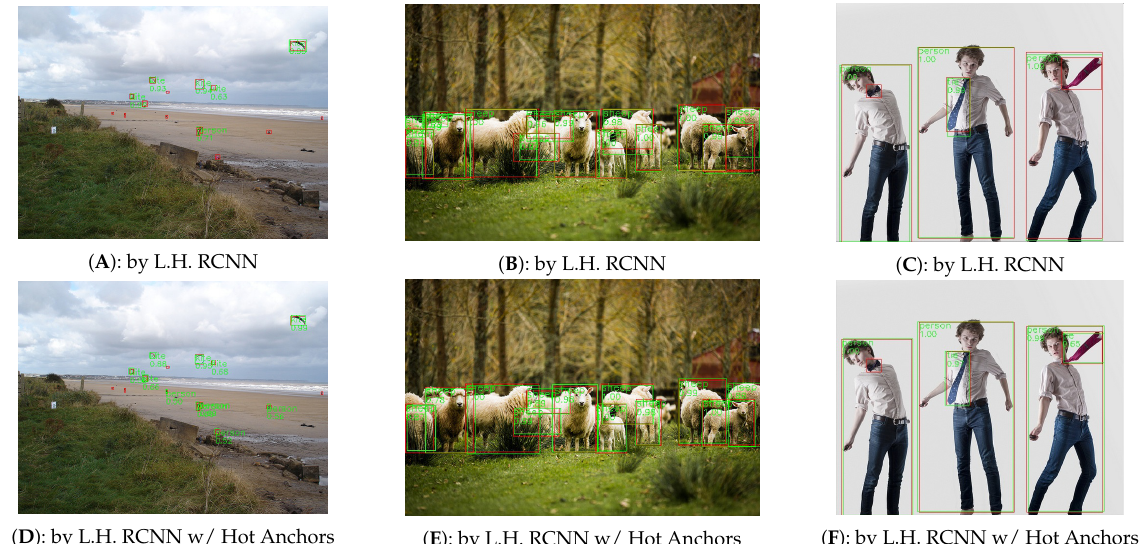
Figure 8. The comparison of detection results between Light Head RCNN [10] and Light Head RCNN with Hot Anchos. The ( A – C ) are the results detected by Light Head RCNN (Abbreviated as L.H. RCNN), and the ( D – F ) are the results detected by Light Head RCNN with Hot Anchors . The green boxes tagged by class label and classification score are the detection results, while the red boxes are the ground-truth boxes. All the images come from COCO2014-minival-set and have been resized to the same size for convenient display.